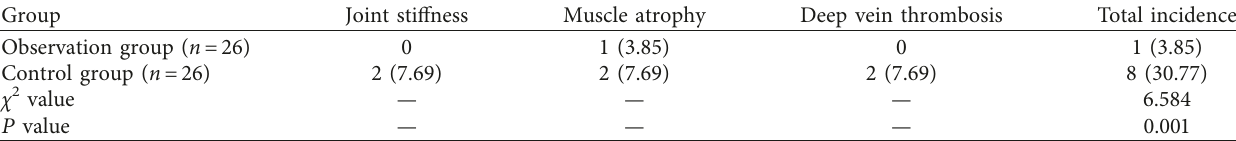
Table 4: Comparison of complications between the two groups [ n